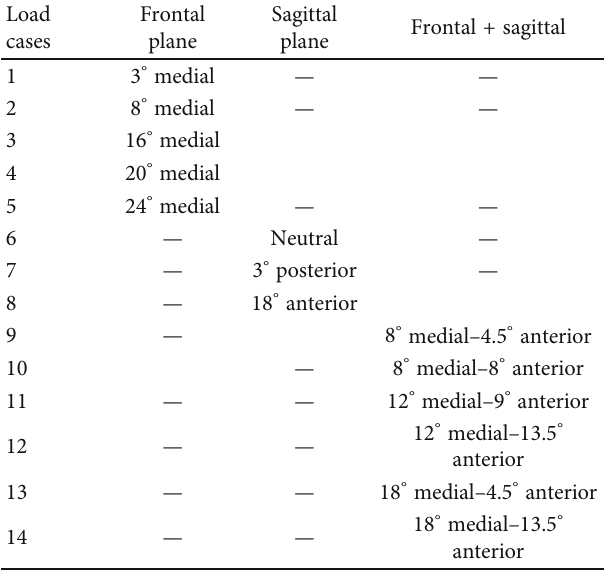
Figure 3: Loadings on femoral head: (a) lateral and medial impacts; (b) compression and tension; (c) external and internal torsions. Table 1: Variation of load direction in the frontal and sagittal